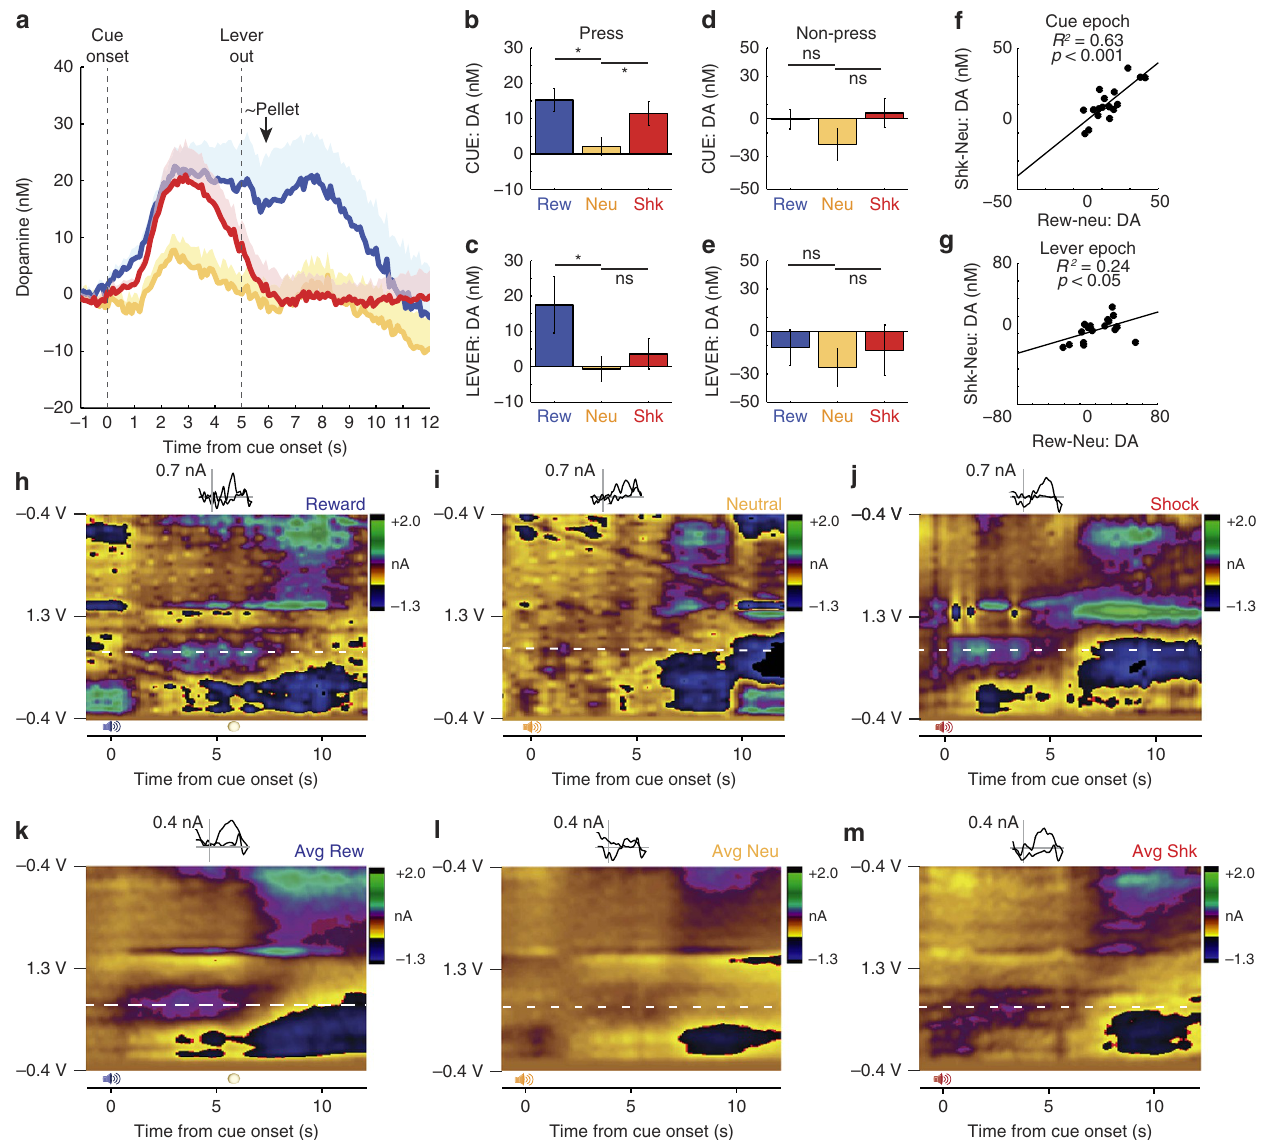
Figure 2 | Average dopamine release ( N ¼ 10 rats) during cue and lever epochs for each trial type. ( a ) Dopamine release (nM) across time for reward (blue), neutral (yellow), and shock (red) trials. Dopamine release is baseline (5s before light onset to light onset) subtracted. ( b – e ) Quantification of DA release for press and non-press responses during the cue epoch (cue onset to lever extension; 5s) and lever epoch (lever extension plus 1s). Bars with asterisks represent significance (T-test; P o 0.05). Error bars represent s.e.m. ( f , g ) Correlation between shock and reward trials normalized over neutral trials (shock minus neutral; reward minus neutral) for both cue epoch and lever epoch. ( h – m ) False-color plots indicate voltammetric current ( z -axis) plotted against applied scan potential ( y -axis) and time ( x -axis) for representative press trials aligned to cue onset for each of the three trial types ( h – j ; Reward, Neutral, and Shock), as well as averaged press trials aligned to cue onset for each of the three trial types ( k – m ; Average Reward, Average Neutral, Average Shock). Insets show cyclic voltammogram for dopamine; scale bars are set to 0.7nA for individual examples and 0.4nA for averages.